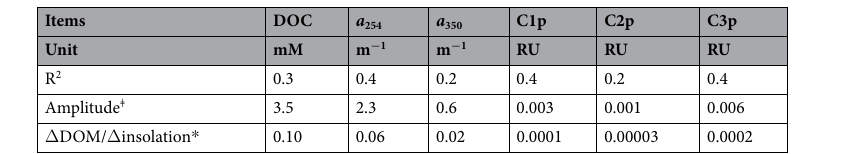
Table 2. Relationship between insolation (15°N in July) and DOM parameters at non-chimney site U1. Correlation excluding the depth above the SMTZ (21 mbsf) and below 118 mbsf (affected by fluids migration) ( p < 0.05). ǂ * Estimated using an insolation rising phase from depth 68 to 118 mbsf (399- to 718-Ka). Insolation unit: Wm − 2